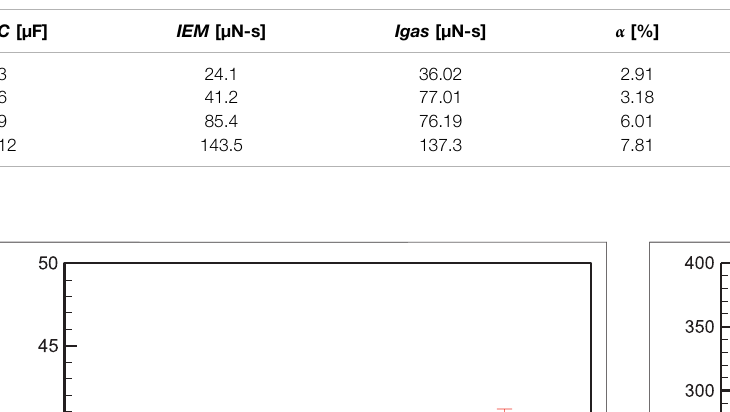
TABLE 6 | APPT performance parameters at different